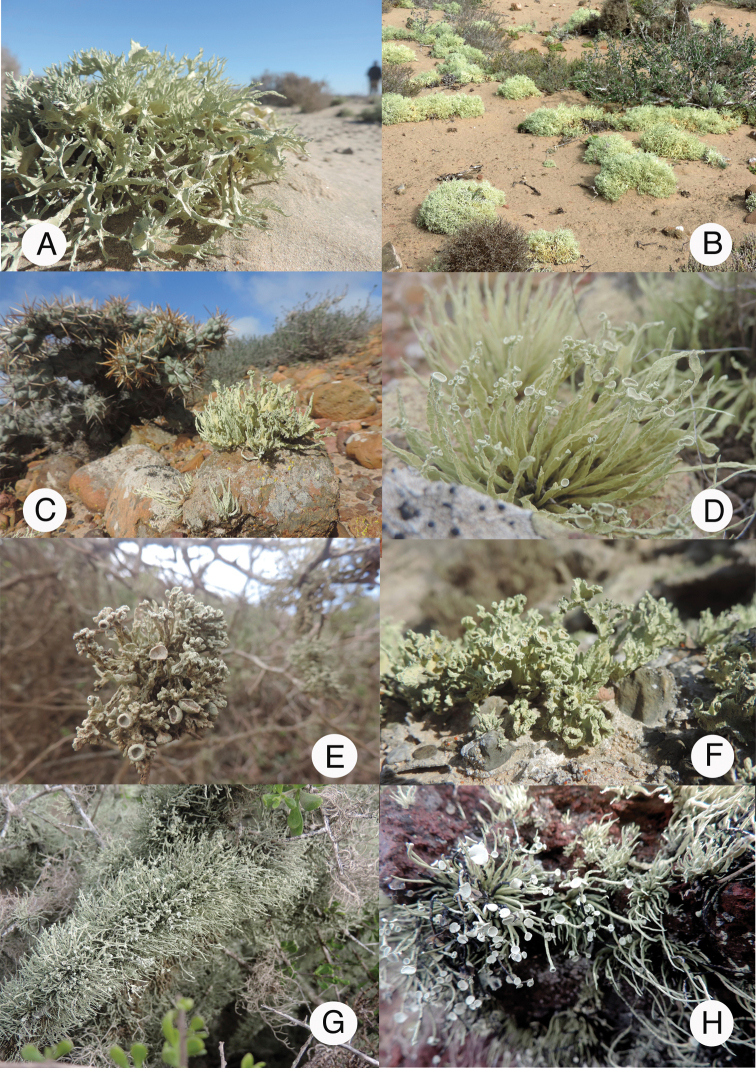
Several species of Niebla and Vermilacinia. Identifications based on Spjut (1996)ANiebla
limicola on sand dunes at Guerrero Negro BCS BN.
marinii at Santo Domingo BCCN.
podetiaforma at Punta Baja BCDN.
siphonoloba at San Antonio BCEVermilacinia
cerebra at San Antonio BCFNiebla
lobulata at Bahía de Tortugas BCS GVermilacinia
leopardina on branches at San Quintín BCHV.
procera on rocks at San Quintín BC. Photographs by E. Sérusiaux and R. Spjut.